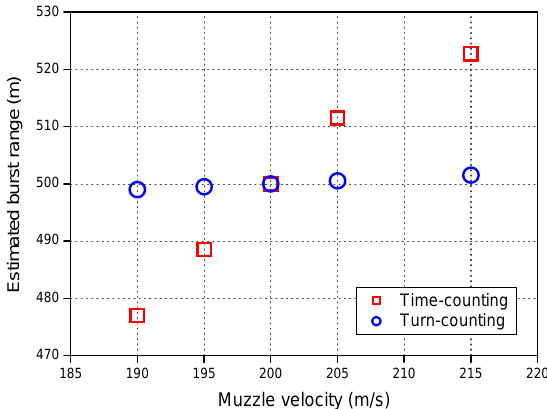
Figure 1. Comparison between estimated burst ranges of time-counting and turn-counting fuzes as function of muzzle velocity deviation using simulation results of PRODAS ® , where nominal muzzle velocity and nominal burst range are assumed as 200 m/s and 500 m,